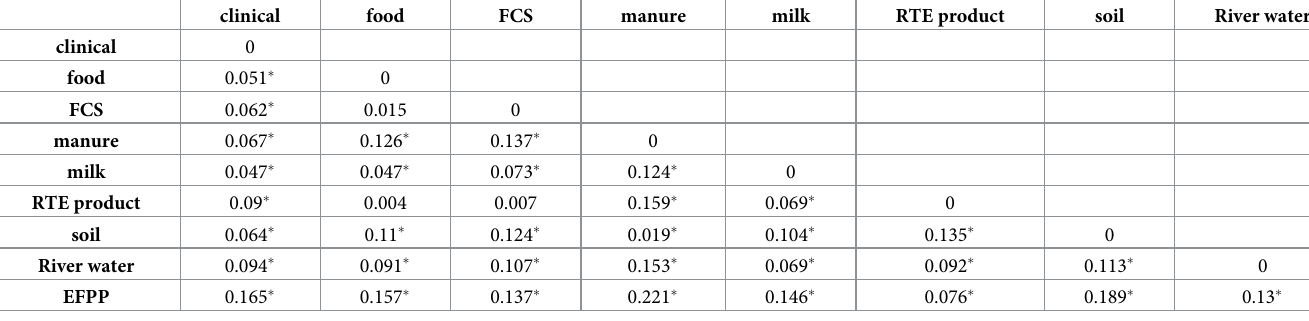
Table 1. Pairwise genetic distances (F ST ) between groups of L . monocytogenes strains isolated from nine different ecological niches.